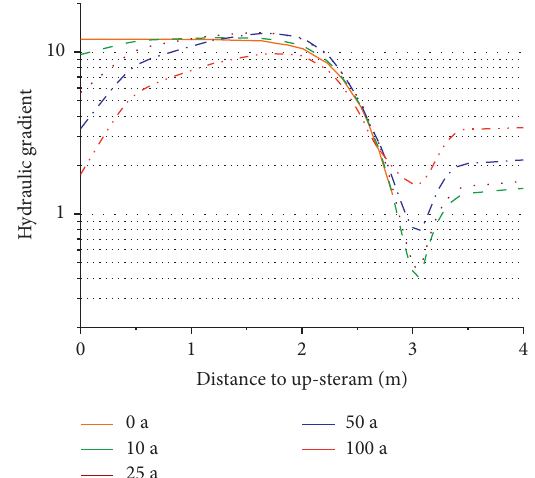
Figure 18: Evolution of the hydraulic gradient in the concrete face slab central line at 84.25m.